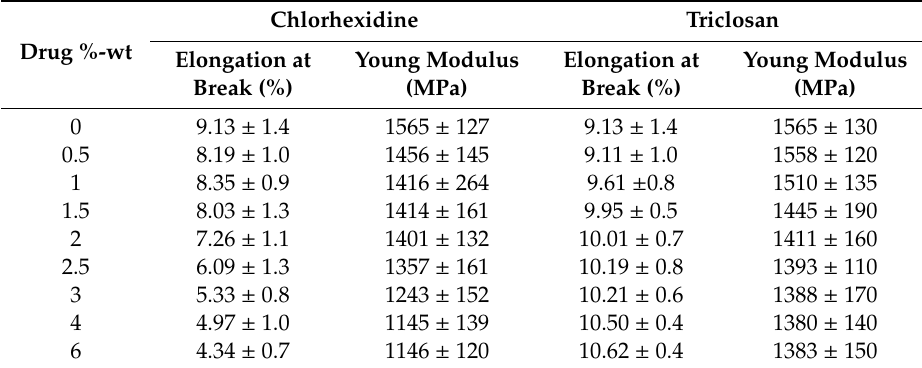
Table 2. Mechanical parameters extracted from stress–strain assays.